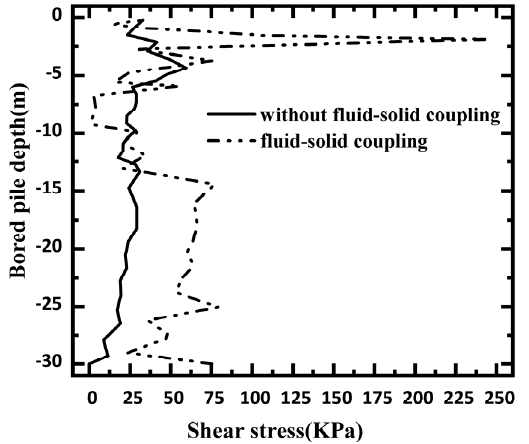
Figure 4. Shear stress diagram of bored pile.